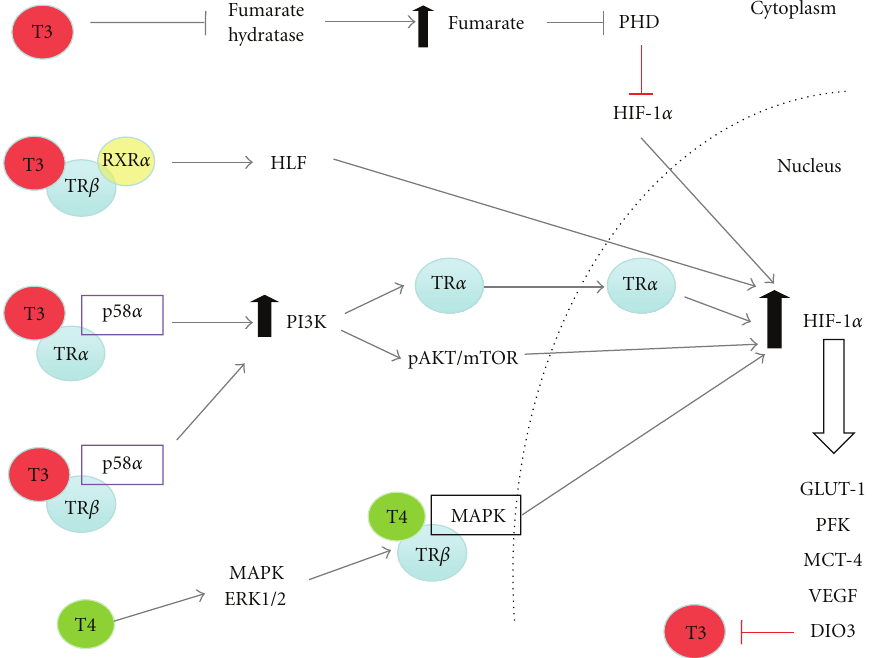
Figure 4: Thyroid hormone-dependent activation of HIF-1 α : T3 and T4 induce HIF-1 α activity by both genomic and nongenomic mechanisms. Genomically, T3 indirectly increases HIF-1 α mRNA by increasing expression of the transcription factor hepatic leukemia factor (HLF), which initiates transcription of HIF-1 α . Non-genomically, T3 stimulates PI3K signalling by promoting the interaction of both TR α and β with the PI3K regulatory subunit p85 leading to enhanced PI3K/AKT/mTOR activity and translation of HIF-1 α mRNA. T3- induced PI3K promotes nuclear shuttling of TR α leading to increased HIF-1 α expression. T3-induced PI3K signalling by either TR α or β is cell specific. T3 inhibits the enzyme fumarate dehydrogenase resulting in the accumulation of fumarate. Fumarate inhibits PHD2 leading to reduced hydroxylation of HIF-1 α and increased protein stabilisation. T4 increases HIF-1 α by stimulating MAPK signalling, leading to enhanced T4/TR β activity and expression of HIF-1 α . Activated HIF-1 α by T3/T4 results in the upregulation of target genes, known to promote tumour cell survival and progression. These include GLUT-1, PFK, MCT-4, and VEGF. Additionally, HIF-1 upregulates DIO3, which inhibits T3 by catalysing the conversion of T3 to the metabolically inactive